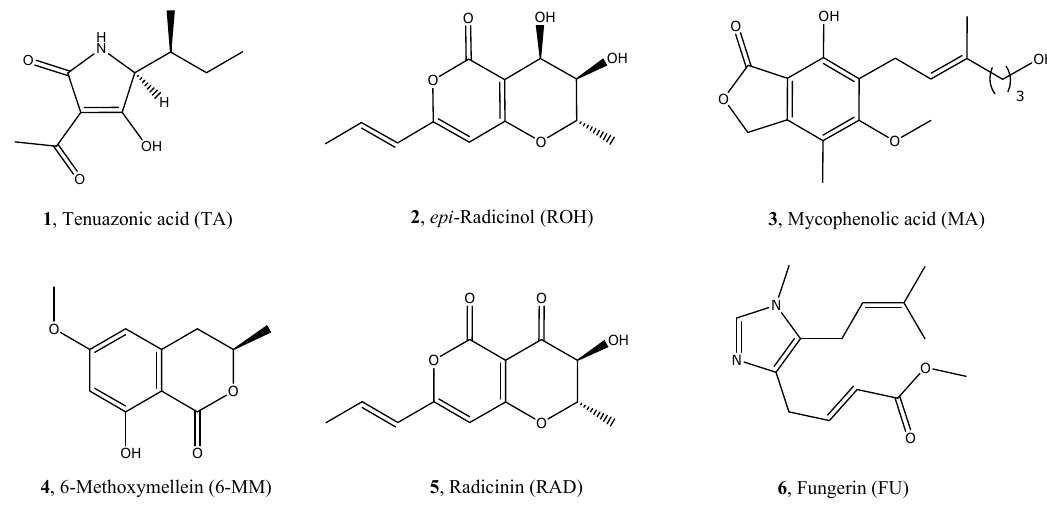
Figure 1. Chemical structures of the selected natural compounds.